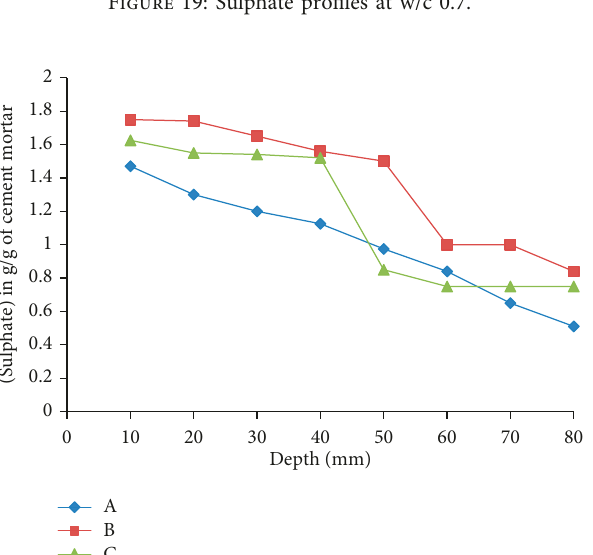
Figure 19: Sulphate profiles at w/c 0.7.